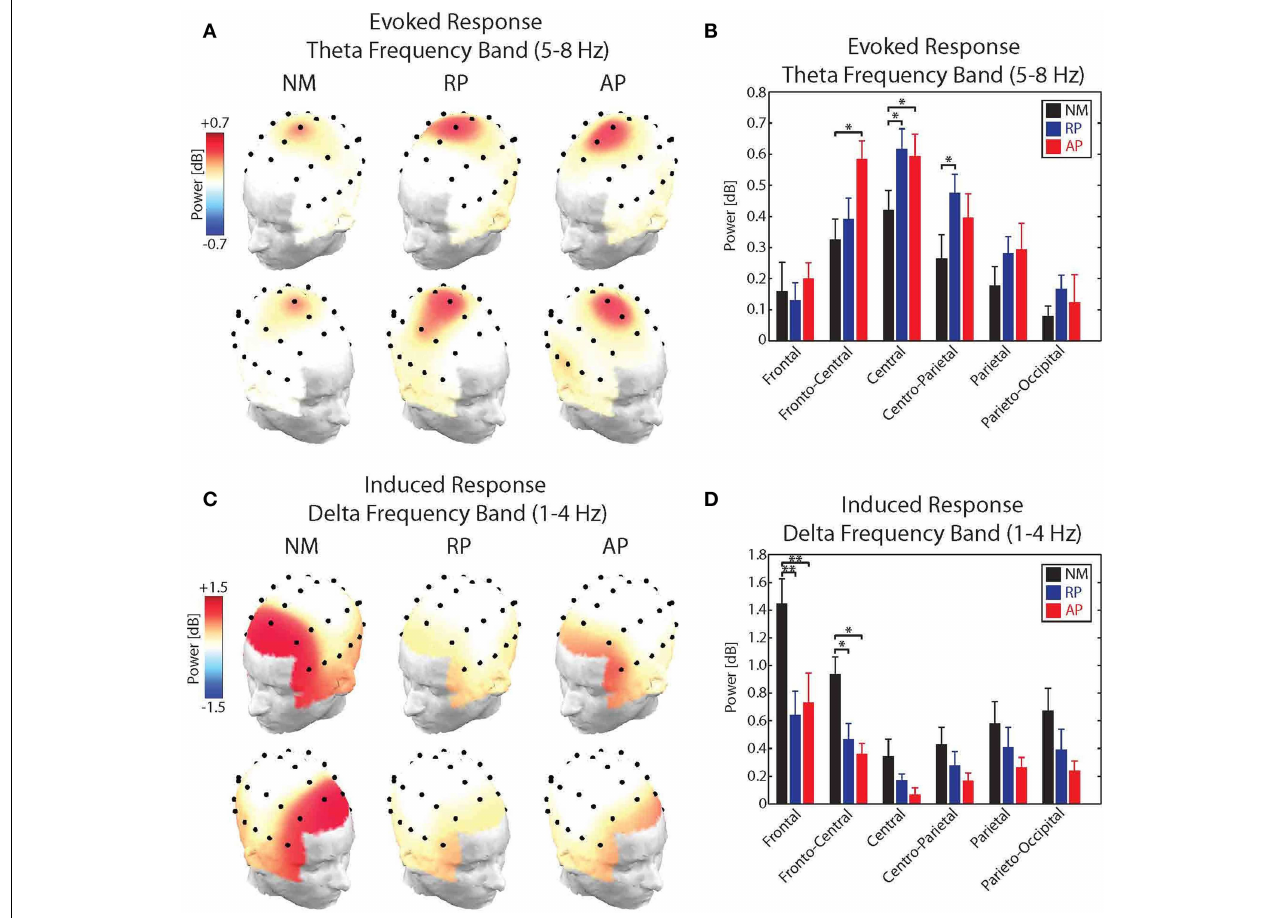
FIGURE 4 | (A) Topographical distribution maps of the power of the evoked theta band (5–8Hz) activity in response to upward and downward pitch shift stimuli across non-musicians (NM), relative pitch (RP), and absolute pitch (AP) musicians. (B) Bar plots representation of the power of the evoked theta band activity for frontal, fronto-central, central, centro-parietal, parietal, and parieto-occipital electrode locations across non-musicians (NM), relative pitch (RP), and absolute pitch (AP) musicians. (C)